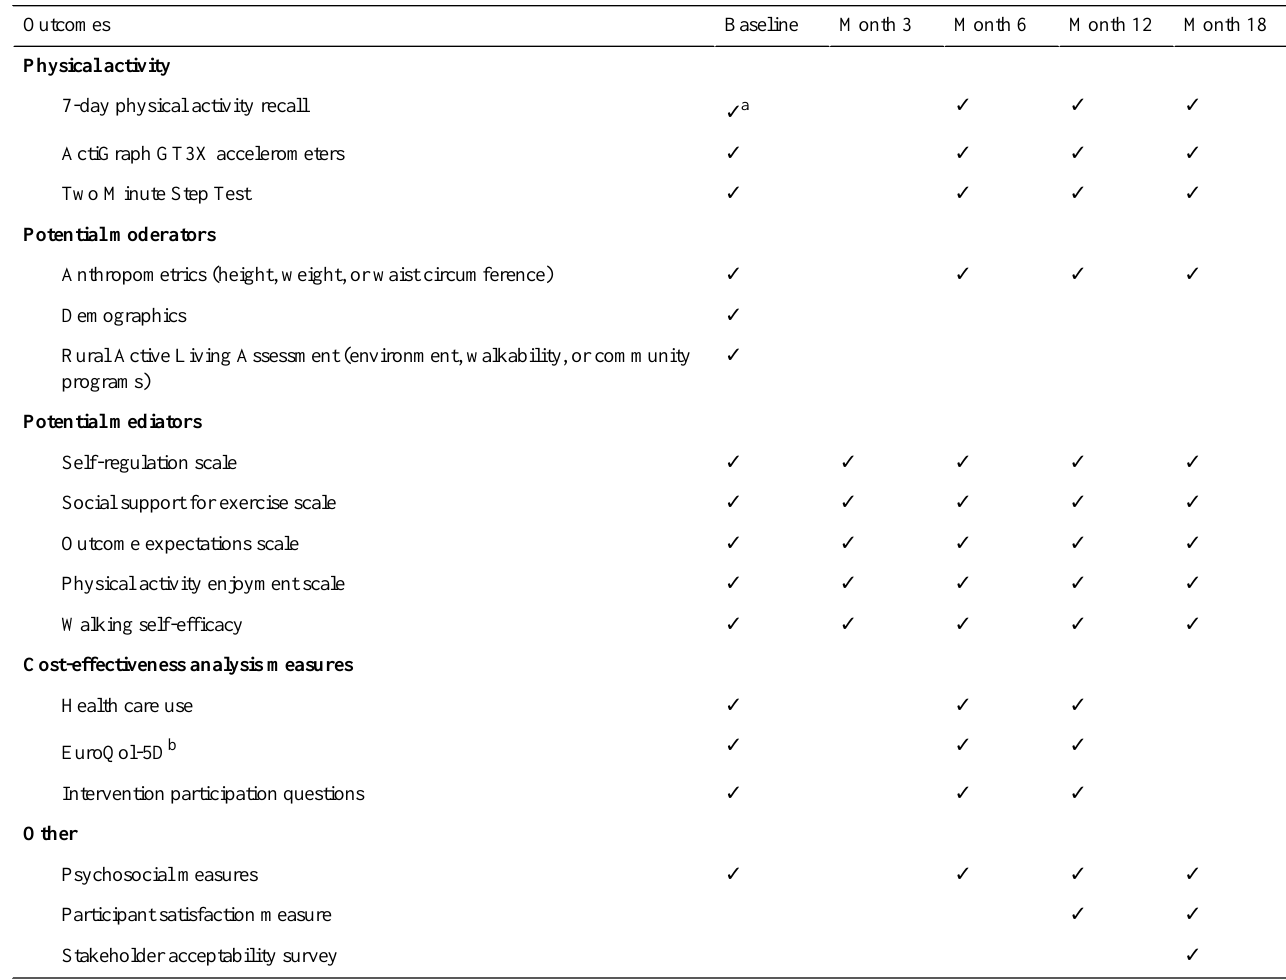
Table 1. Deep South Interactive Voice Response System–Supported Active Lifestyle study